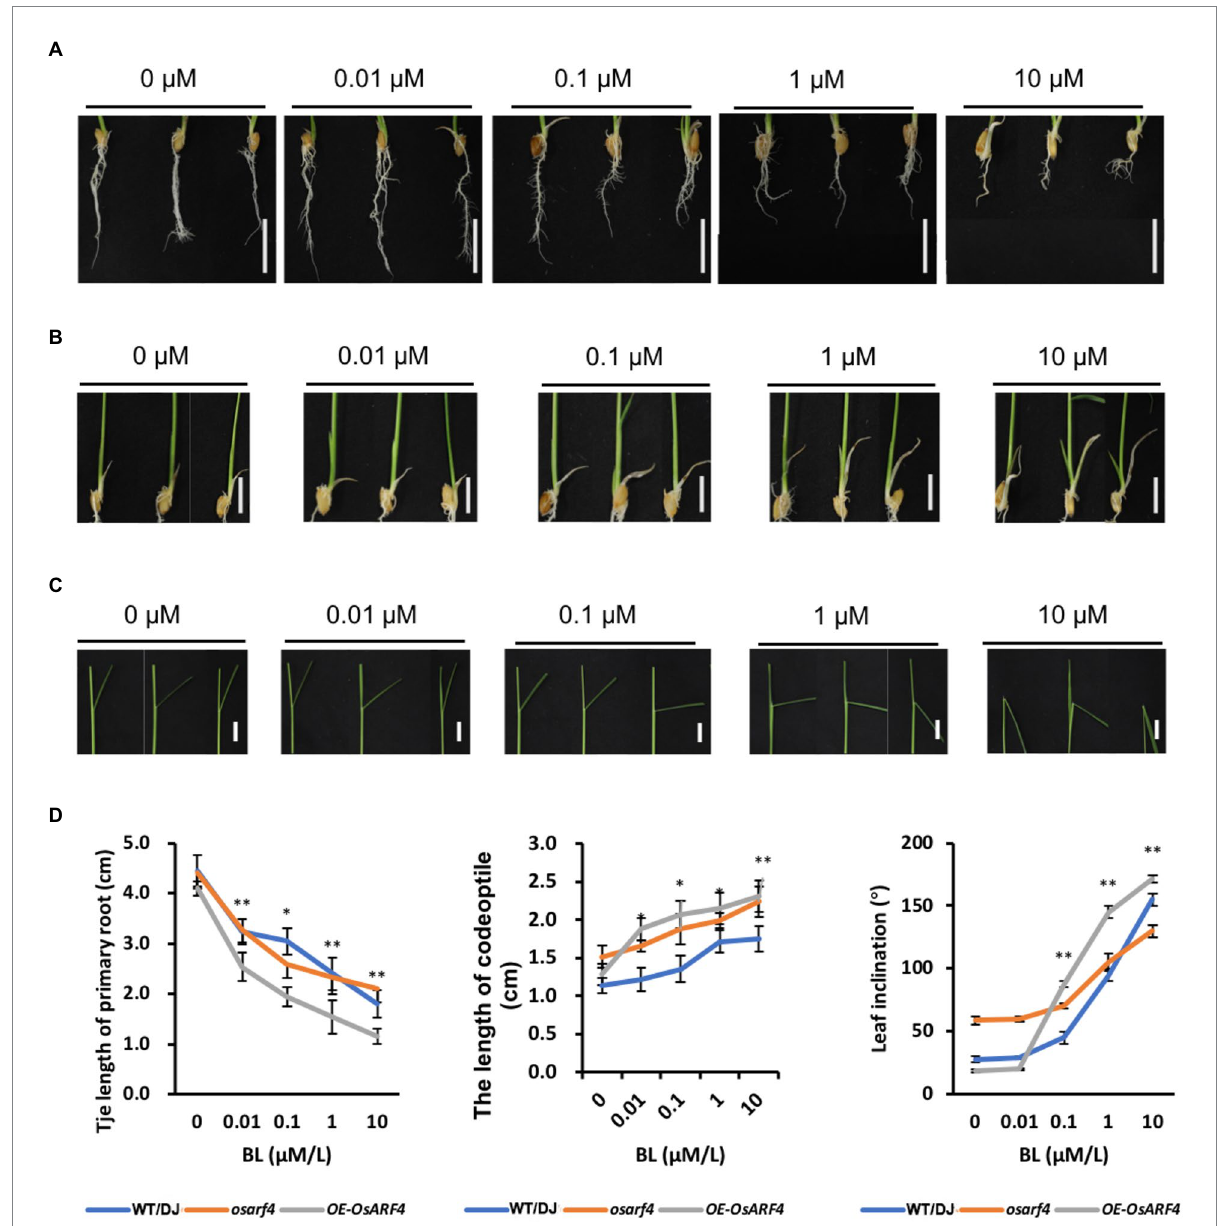
FIGURE 6 OsARF4 mediates the morphological response of rice to 24-epibrassinolide (24-eBL). (A–C) primary root (PR; A ), coleoptile elongation (B) , and Leaf inclination (C) response to 24-eBL treatments. Panels from left to right show roots of seedlings of WT/DJ, osarf4 mutants, and OsARF4- overexpressing lines grown for 7 days (A,B) or 3 days (C) under 0, 0.01, 0.1, 1, and 10 μ m 24-eBL treatment. Bars = 2 cm in A and 1 cm in B/C . (D) Statistical analyses of PR length, coleoptile, and leaf inclination in WT/DJ, osarf4 mutants, and OsARF4 -overexpressing lines under above indicated 24-eBL treatments ( n = 10). * p < 0.05 and ** p < 0.01 based on Student’s t-test